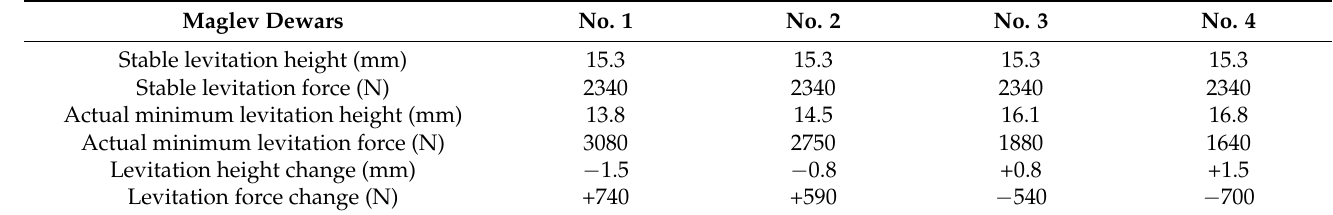
Table 6. Variation in the levitation heights and levitation forces of Dewar under V 0 = 600 km/h and 10 mm air gap.